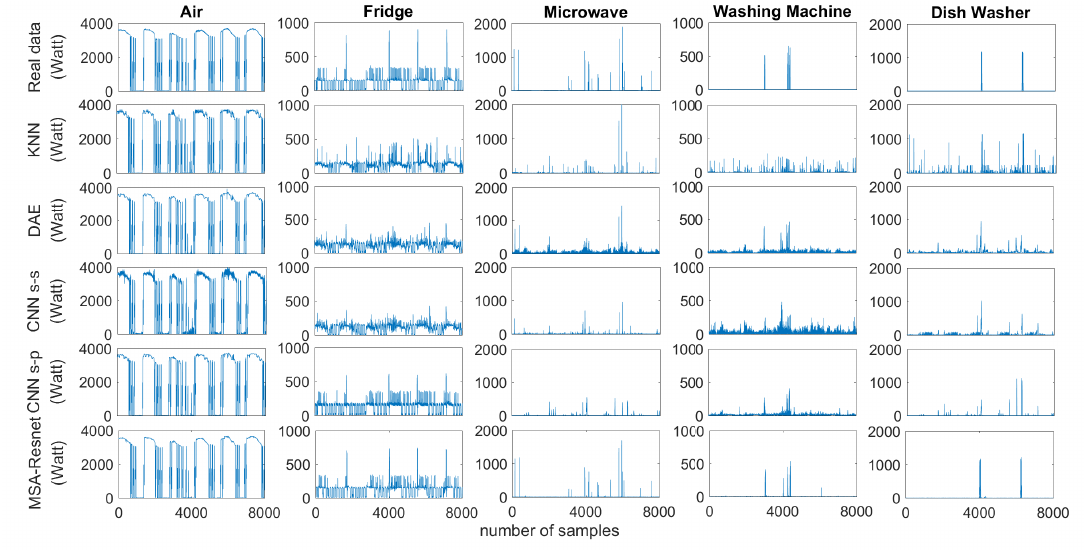
Figure 7. Comparison load disaggregation results of Household 25 in the WikiEnergy